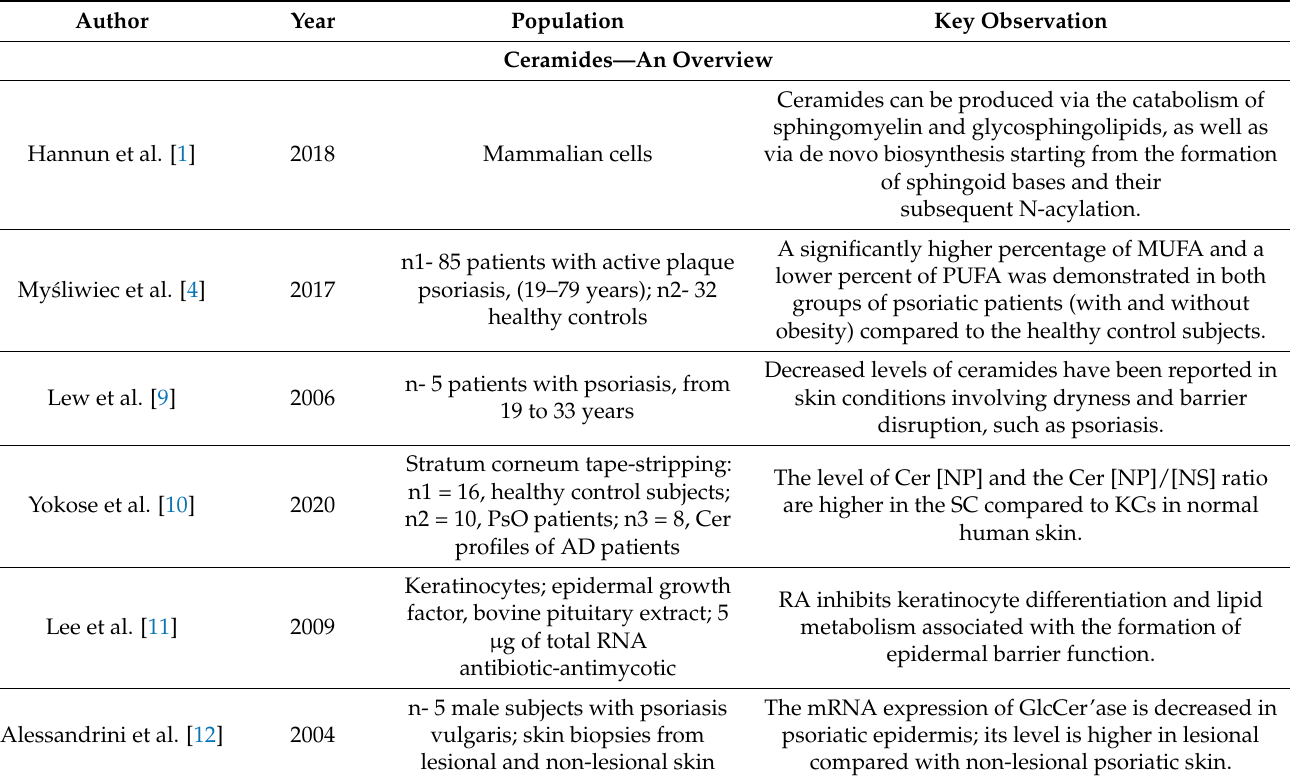
Table 1. Summary of the studies on the role of ceramides in the pathogenesis of